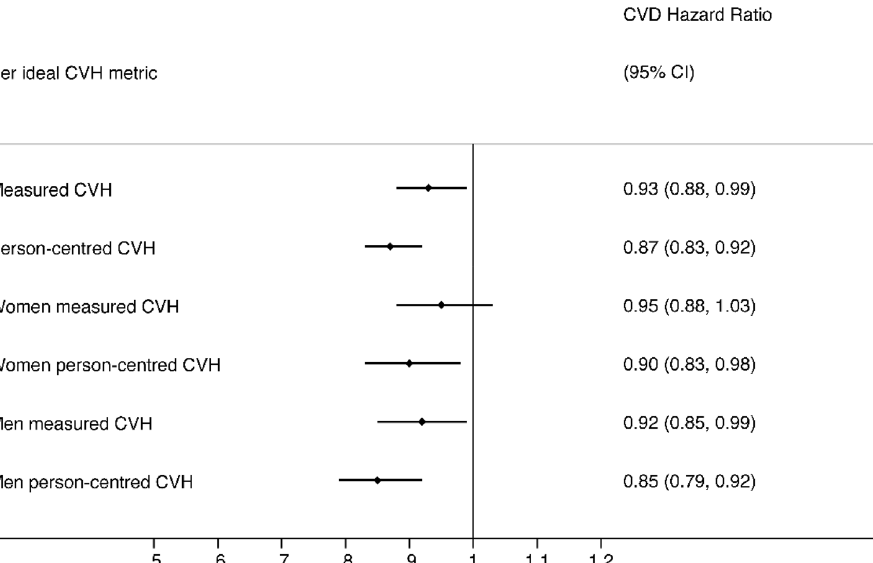
Figure 3. Hazard ratios and 95% confidence intervals for incident CVD per unit increase in ideal measured and person-centered CVH metrics, overall and by sex. Hazard ratios and 95% confidence intervals were estimated by Cox proportional models using age as a timescale, stratified by birth year (5-year intervals), and adjusted for baseline sex (when appropriate), cohabitation status, educational attainment, occupational category, alcohol use, and CVD family